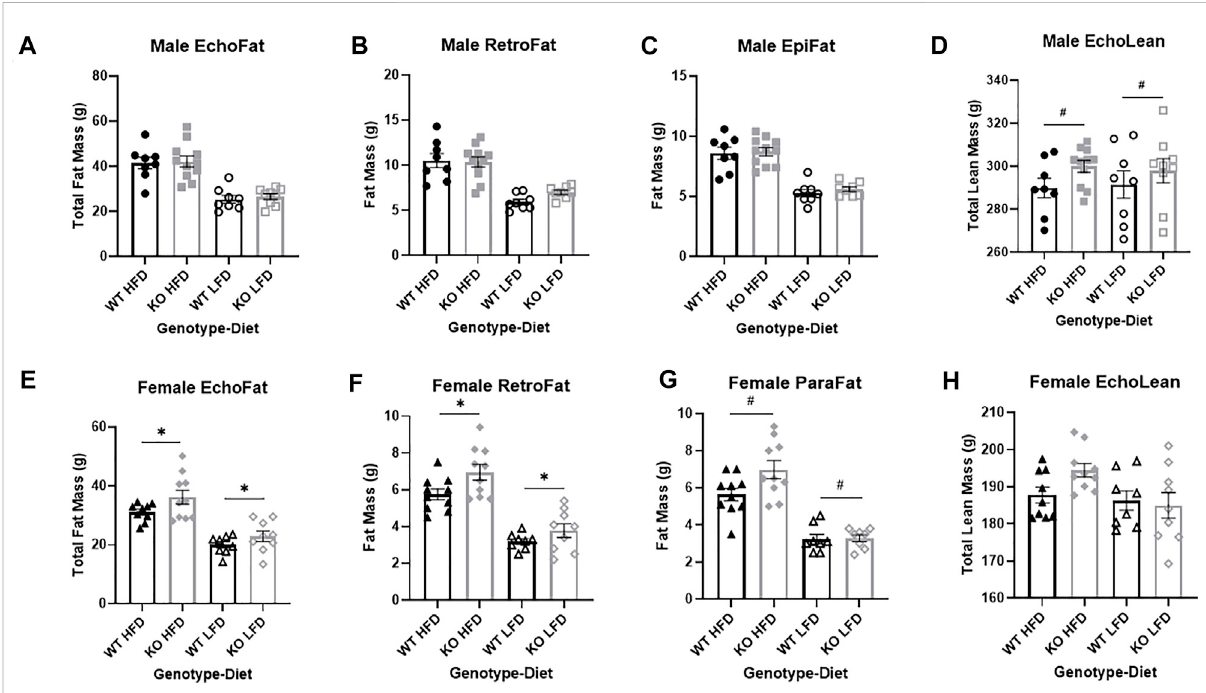
FIGURE 5 Fat mass and lean mass in wild-type (WT; black) and Krtcap3 knock-out (KO;grey) rats, for males (top)and females(bottom). After 10 weeks on diet, (A) there were no differences intotal fat mass using EchoMRI analysis (EchoFat) betweenWT males (circle)and KO males (square), regardless of dietcondition(highfatdiet(HFD; fi lledsymbols)andlowfatdiet(LFD;opensymbols)).Ateuthanasia,therewerenodifferences (B) inretroperitoneal fat (RetroFat) mass or in (C) Epididymal fat (EpiFat) mass. (D) Earlier at EchoMRI analysis there were slight differences in lean mass (EchoLean) between WT males and KO males, but no differences between males on a HFD or a LFD. On the other hand, (E) KO females (diamond) on both diets had increased total fat mass using EchoMRI analysis compared to WT females (triangle). At euthanasia, KO females had (F) increased RetroFat mass, and (G) a trend toward increased parametrial fat (ParaFat) mass. Earlier at EchoMRI analysis, (H) there were no differences in lean mass between WT females and KO females in either diet condition. Signi fi cance represents main effect of genotype at the following signi fi cance levels: # p < 0.1, * p < 0.05, ** p < 0.01. Diet effects were also seen as reported in the “ Results ”